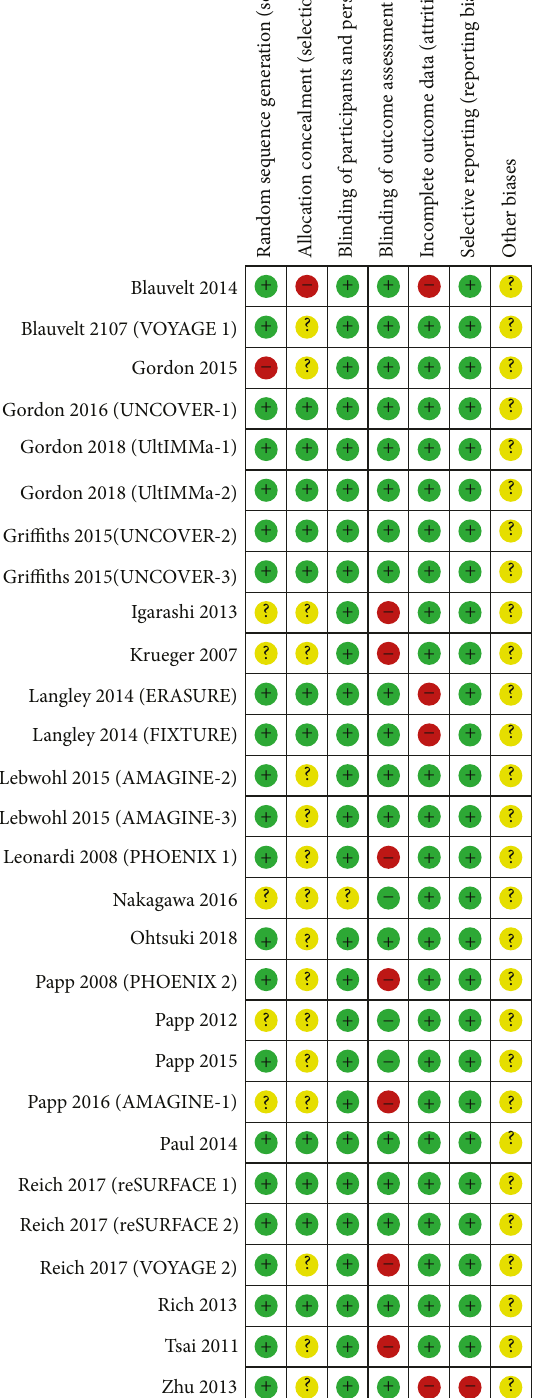
Figure 7. The corresponding forest plot is detailed in Supple- mentary Figure 4.